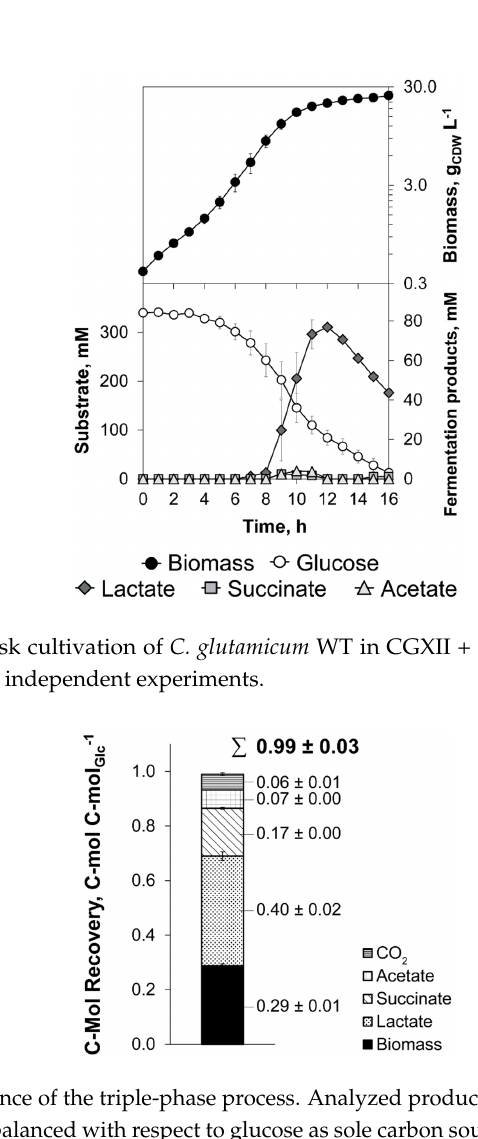
Figure A2. Carbon balance of the triple-phase process. Analyzed products (biomass, lactate, succinate, acetate and CO 2 ) were balanced with respect to glucose as sole carbon source over the entire cultivation period of 0–16 h (Figure 1A). Error bars represent the SD of four independent experiments.